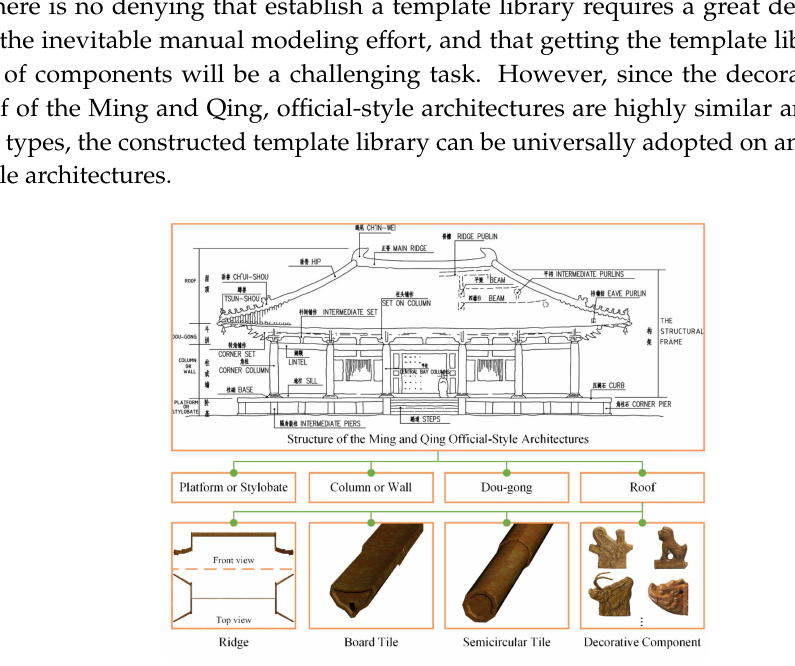
Figure 1. Decomposition of the Ming and Qing o ffi cial-style architecture structures [21].